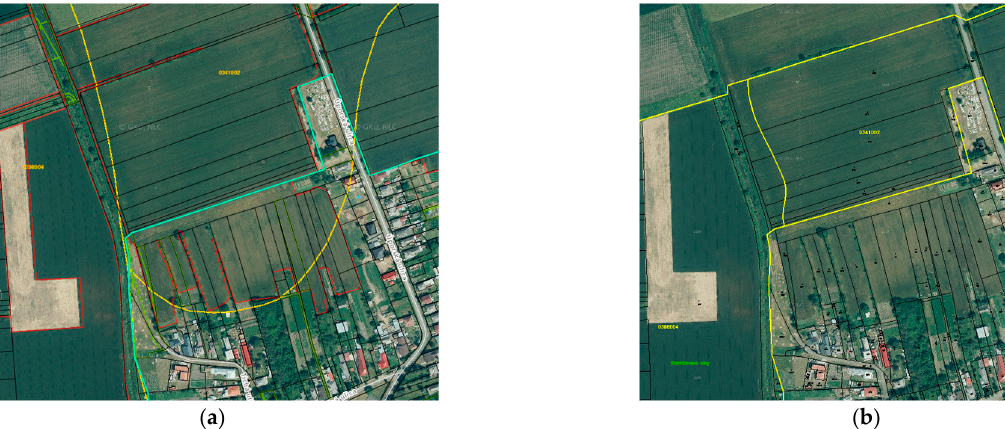
Figure 17. Illustration of differences in the registration of EPEU areas in the cadastral unit after LC registration into the real estate cadastre: ( a ) Agro layer of ZBGIS; ( b ) from the real estate cadastre.